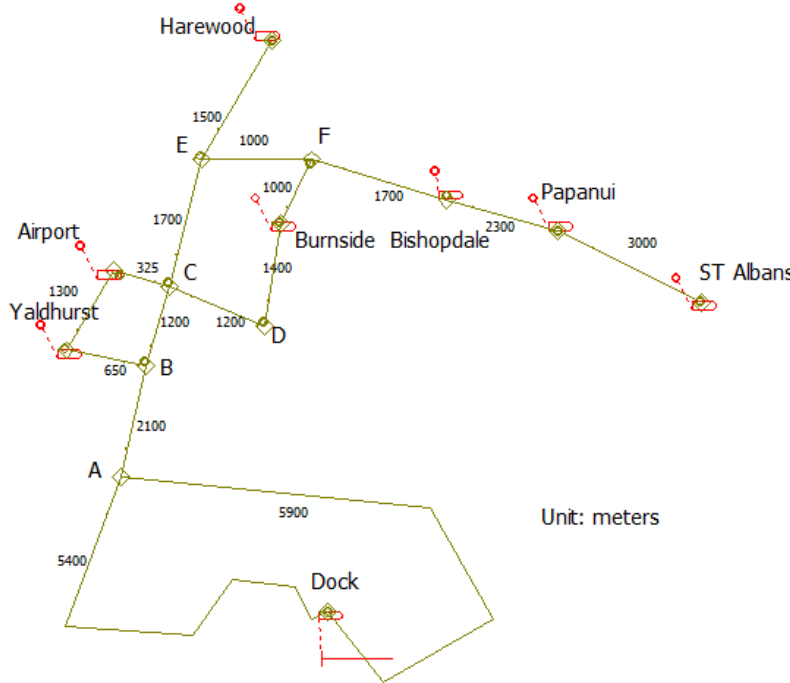
Figure 6. Freight network of the intersection-based model.